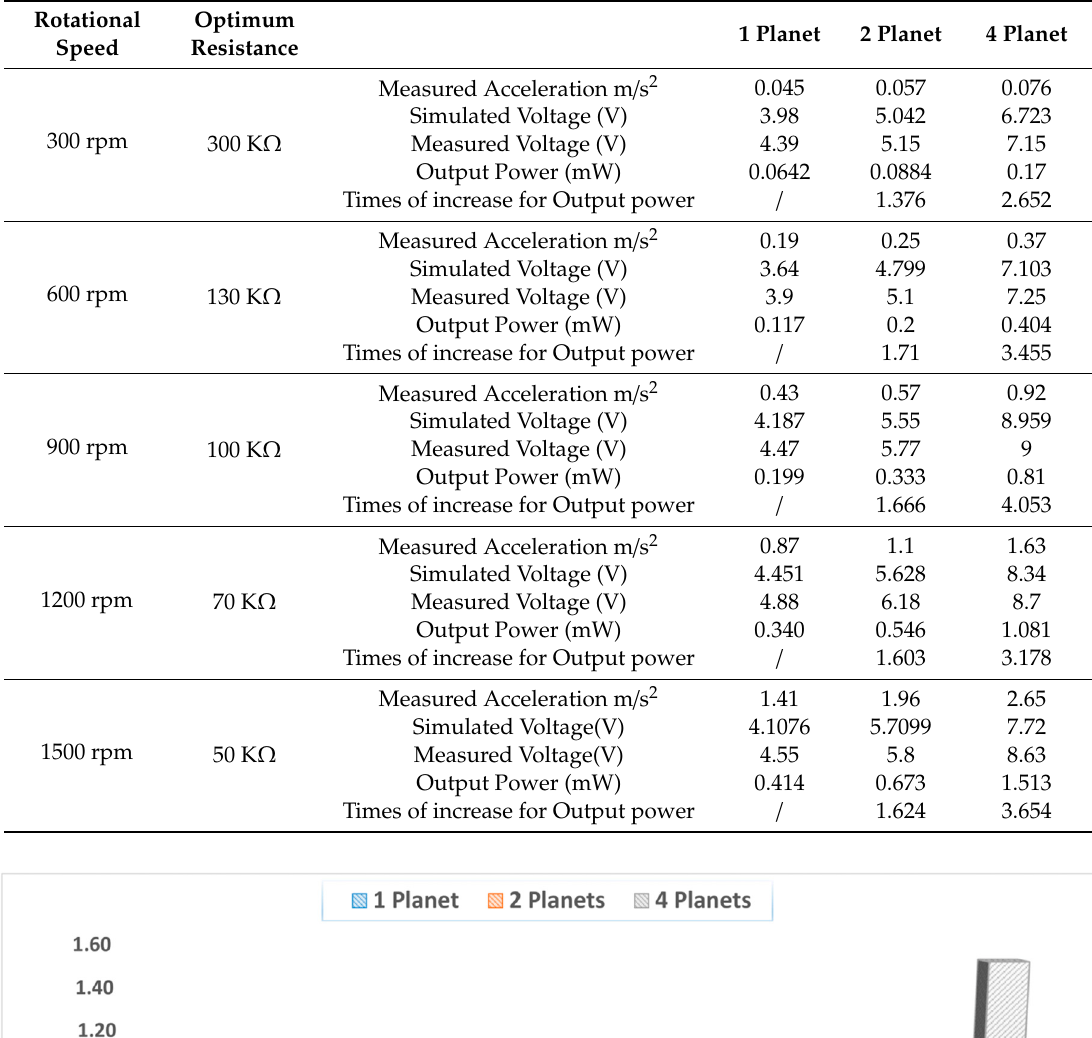
Table 4. Comparison of Voltage in Simulation and Experiment Results and Output Power and Its Increase as Planet Numbers Increase.